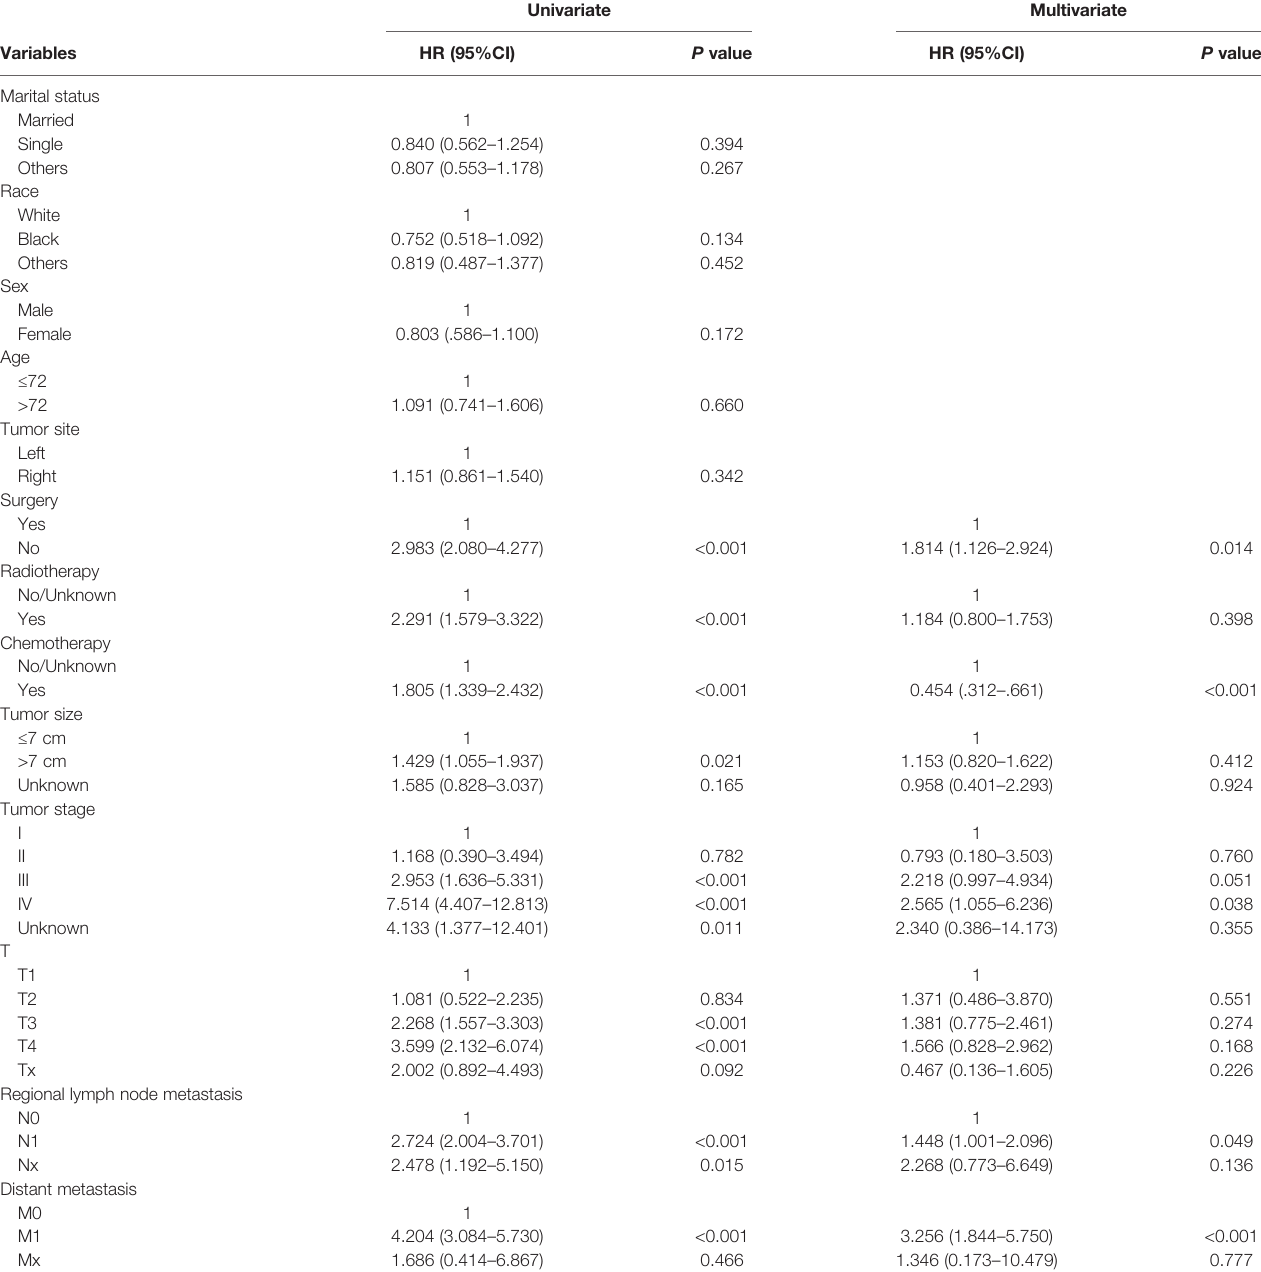
TABLE 2 | Univariate and multivariate analyses of the CSS of the patients.